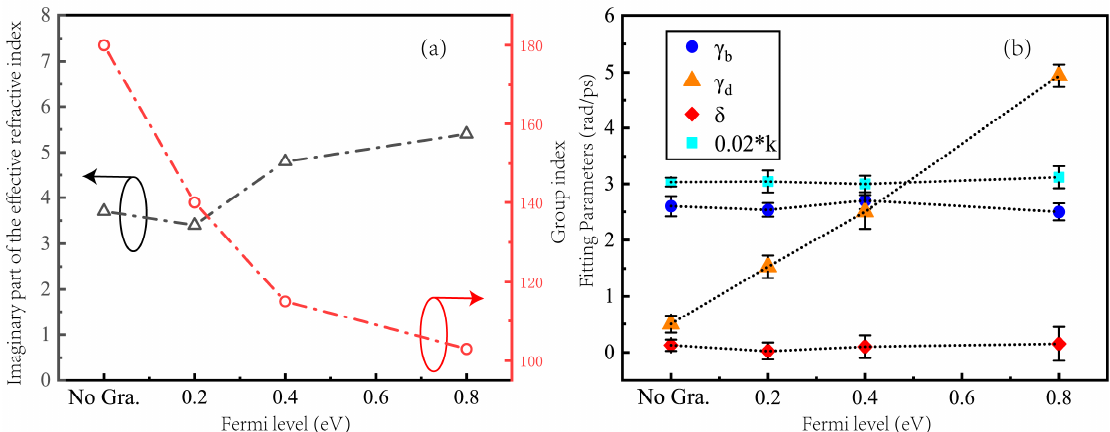
Figure 5. ( a ) The maximum distribution of group index and imaginary part of the effective refractive index when no graphene and graphene Fermi levels are 0.2 eV, 0.4 eV and 0.8 eV. ( b ) The fitted values of the correlation coefficients in the coupled harmonic oscillator model with the Fermi level of graphene varying from 0.2 eV to 0.8 eV. The unit of k is rad 2 ps − 2 .